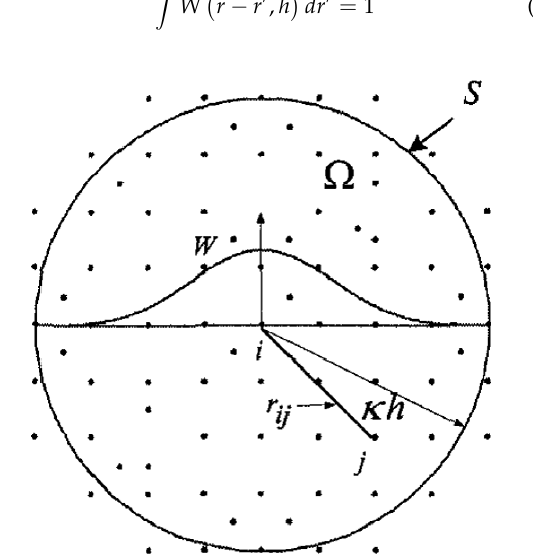
Fig. 2. Particle i with a radius of k.h in the support domain of the smoothing function W (Nguyen et al.